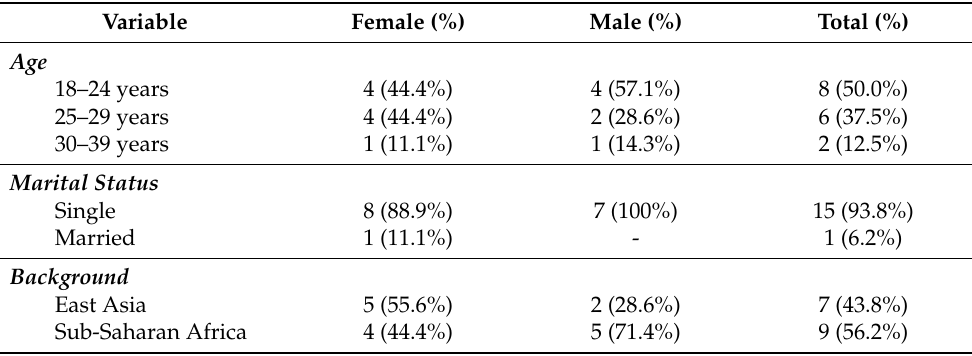
Table 1. Socio-demographic characteristics of